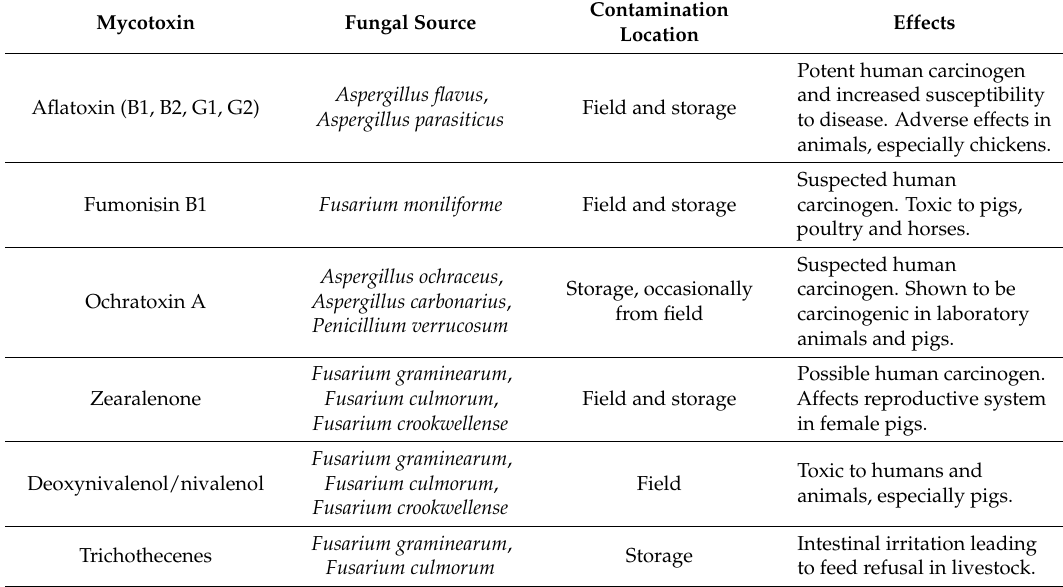
Table 2. Different mycotoxins affecting maize quality